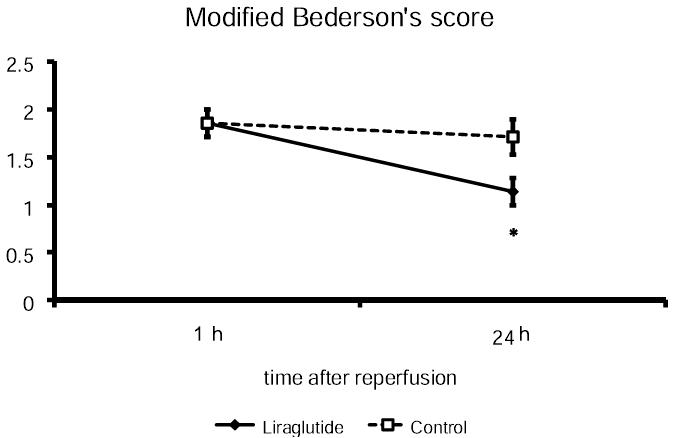
Figure 1. Amelioration in behavioral scores. Post-stroke administration of liraglutide reduced modified Bederson’s score at 24 h after reperfusion, although the scores of both groups did not differ at one hour after reperfusion just before administration of liraglutide or saline. * p < 0.05 vs. control group.